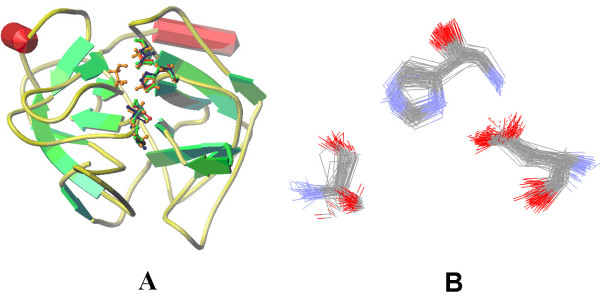
The superposition output of the CMASA. A: a structure (pdbid:1mct) searched to a functional sites database (nrCSA); highest five ranks were shown. The matched active sites were labelled as ball and stick. B: a functional site (1mct catalytic site: H57, D102 and S195) searched to the nrPDB; the hits with P-value < 1.0 × 10-4 were shown (83 hits).